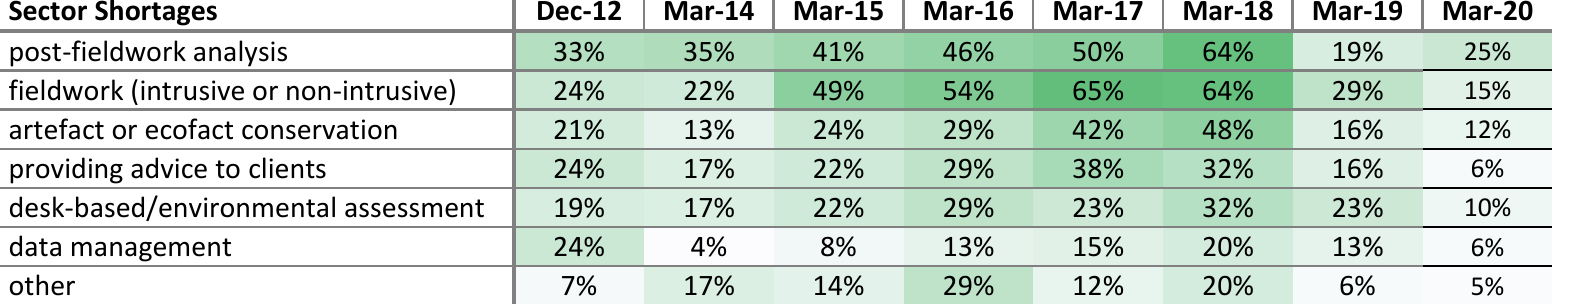
Table 24: Skills shortages from 2012 to 2020. Percentages calculated on total responses to all skills questions and not just those to this specific question. The assumption is made that those who did not respond did so because they did not believe there are sector